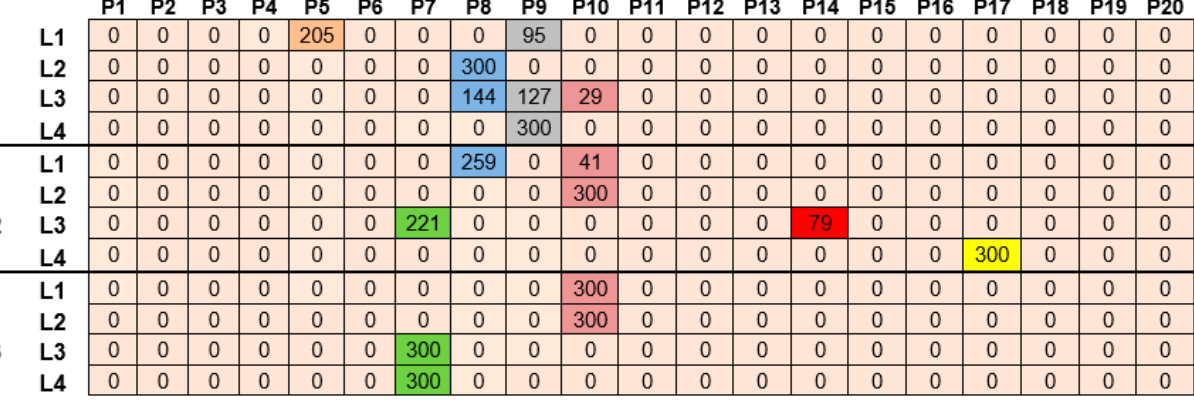
Figure 31. Allocated alternative crop succession to the land unit under scenario I condition (ha).